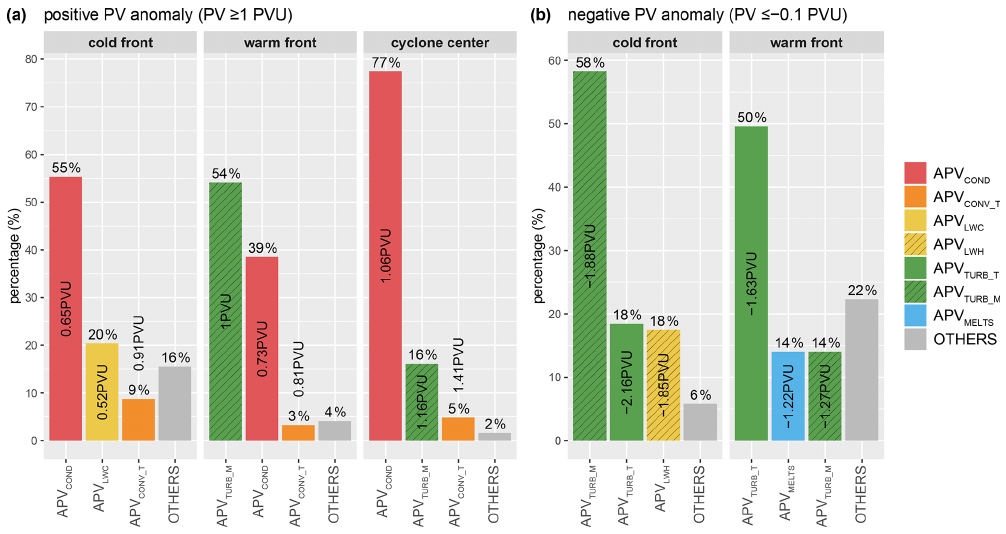
Figure 5. As Fig. 4 but for the 144 cyclones of the warm season.